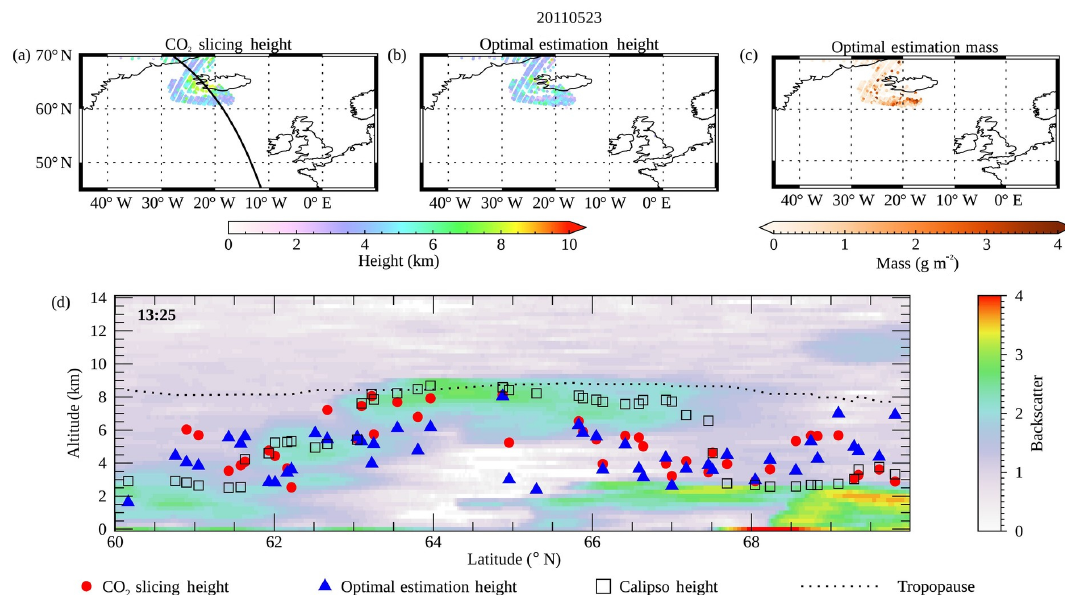
Figure 13. Same as Fig. 10 for 23 May